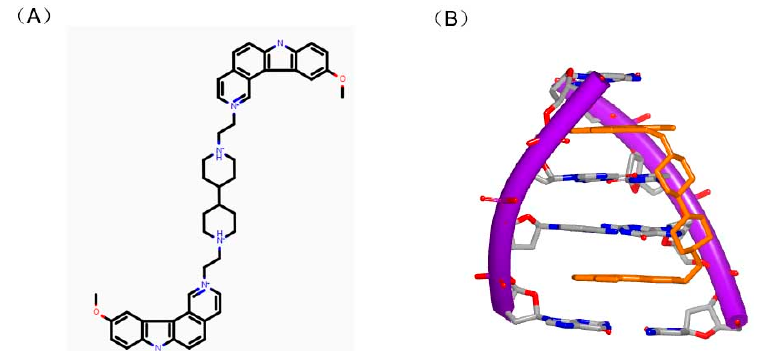
Figure 13. ( A ) Chemical structure of dimer of ditercalinium; and ( B ) complex of a DNA duplex with ditercalinium (PDB code: 1D32). The orange structure represents the small molecule; the purple structure represents the backbone of nucleic acid; the blue and red atoms in the molecule represent nitrogen and oxygen atoms, respectively.